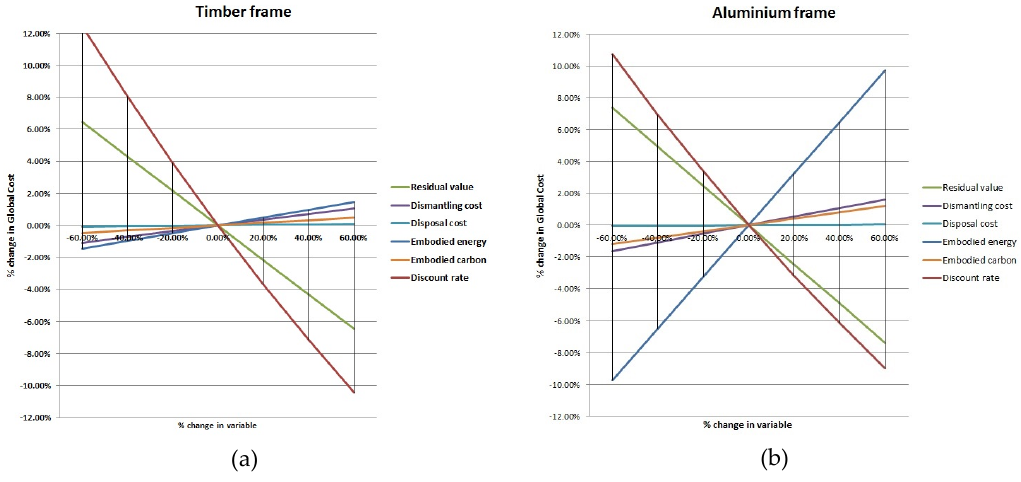
Figure 2. Sensitivity analysis: spider graph: ( a ) Timber frame; ( b ) Aluminum frame.